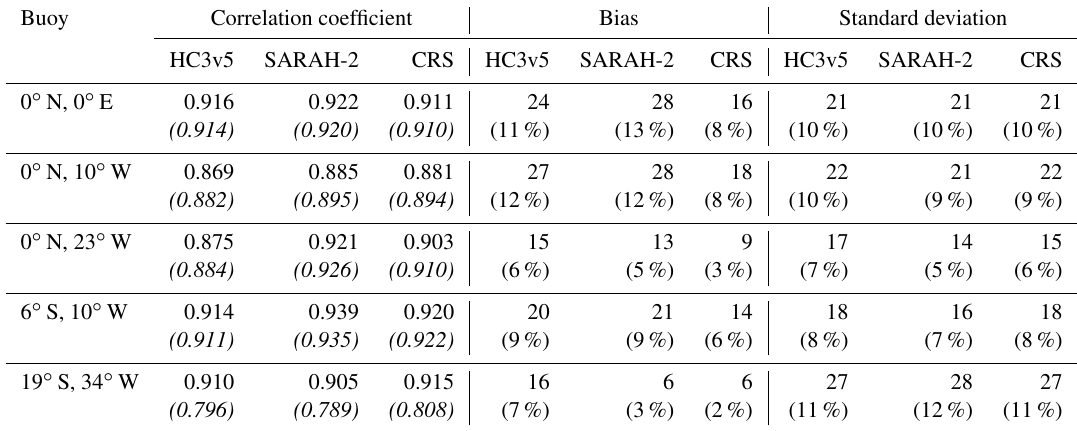
Table 4. Details for each PIRATA buoy and each satellite-derived data set: correlation coefficient between measurements and estimates from satellite-derived data sets for irradiance and clearness index (in italics), bias and standard deviation (Wm − 2 ) between measurements and estimates for irradiance with relative values (in brackets) for daily means in the period 2012–2013. Buoy